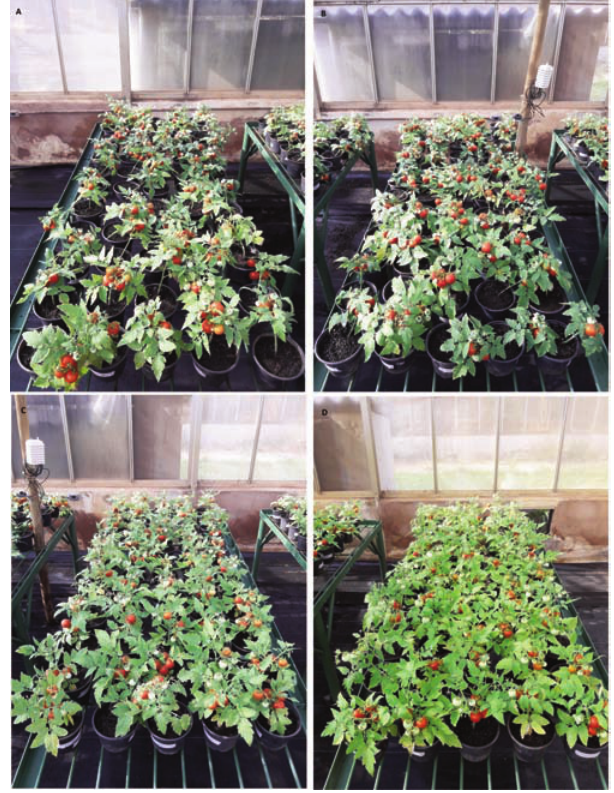
Fig. 2 - Ornamental/miniature tomato plants visual aspect when precocity stage was reached. (A) from 50 cm³ plugs with hydrogel amendment; (B) from 50 cm³ plugs without hydrogel amendment; (C) from 18 cm³ plugs without hydrogel amendment; (D) from 18 cm³ plugs with hydro-